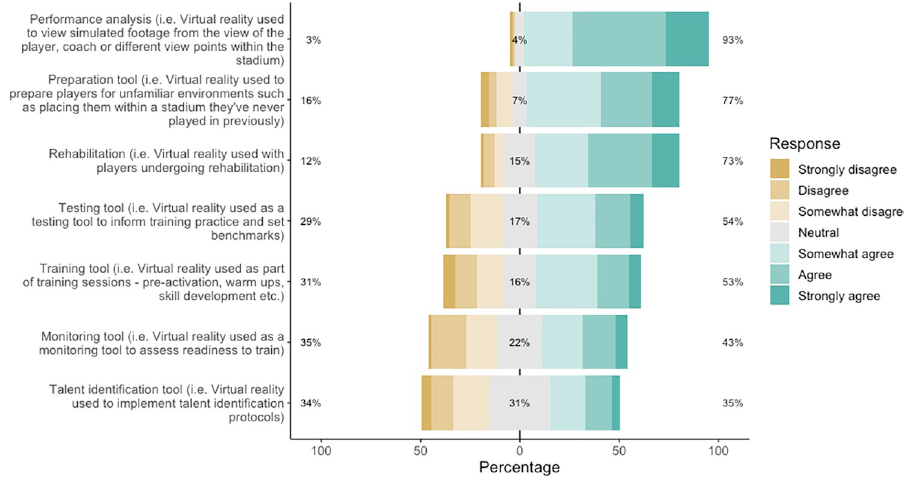
Fig 2. Responses by practitioners to statements regarding how VR should be used. Percentages indicate overall disagreement, neutral and overall agreement, from left to right respectively.